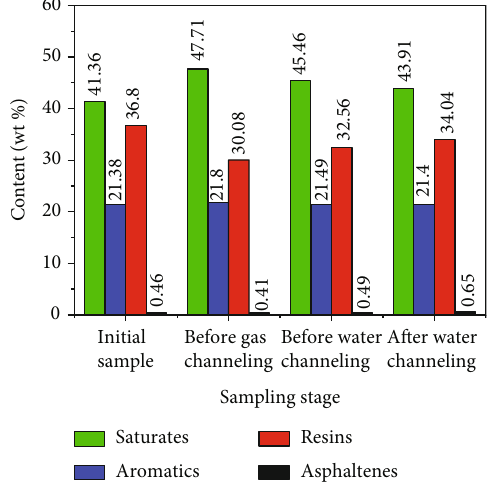
Figure 6: Comparison of four components of crude oil produced during fl ue-gas-assisted steam fl ooding.